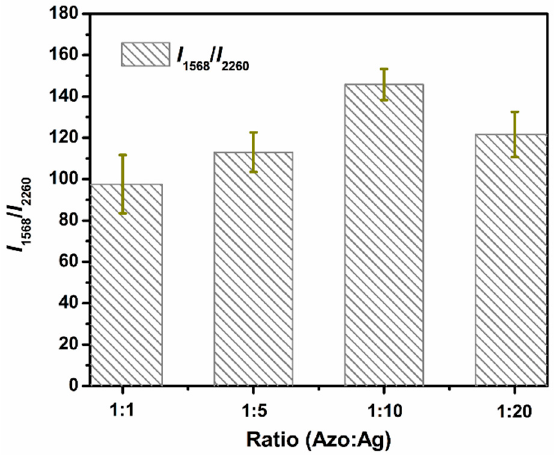
Figure 4. Mixing ratio of azo solution and Ag NPs-dependent SERRS intensity ratio ( I 1568 / I 2260 ). The azo solution was derived from 1 mg/mL benzocaine. Excitation wavelength: 532 nm. The error bars were made according to at least three data sets.